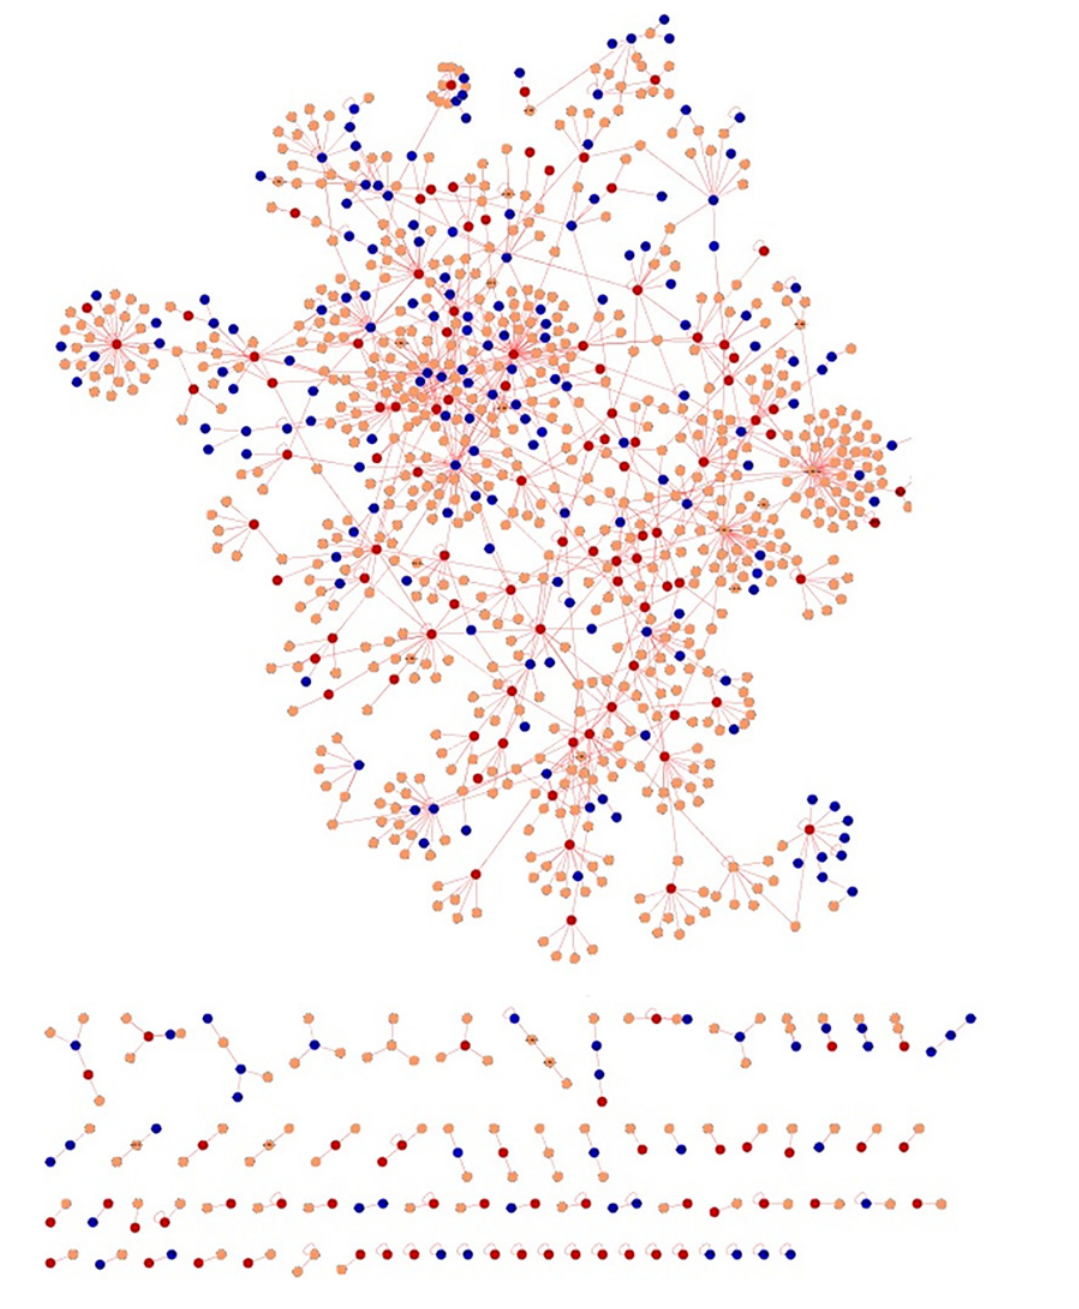
Fig 6. Psoriasis diseaseome including proteins from RA. Brown nodes — proteins involvement in psoriasis, red nodes — common proteins shared by RA and psoriasis and blue nodes — indirect interactions.